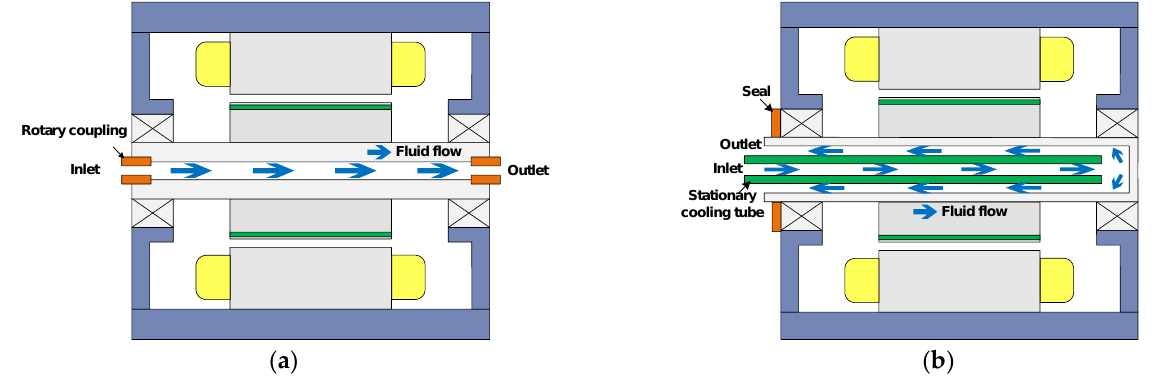
Figure 12. Hollow-shaft forced liquid cooling. ( a ) Direct-through [164]. ( b ) Recirculating